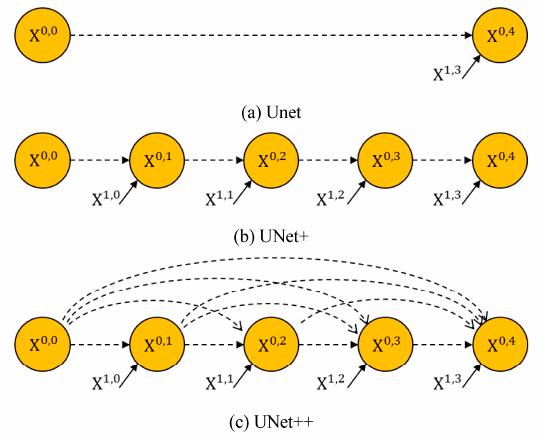
Figure 1. The first skip pathway of UNet, UNet+ and UNet++.